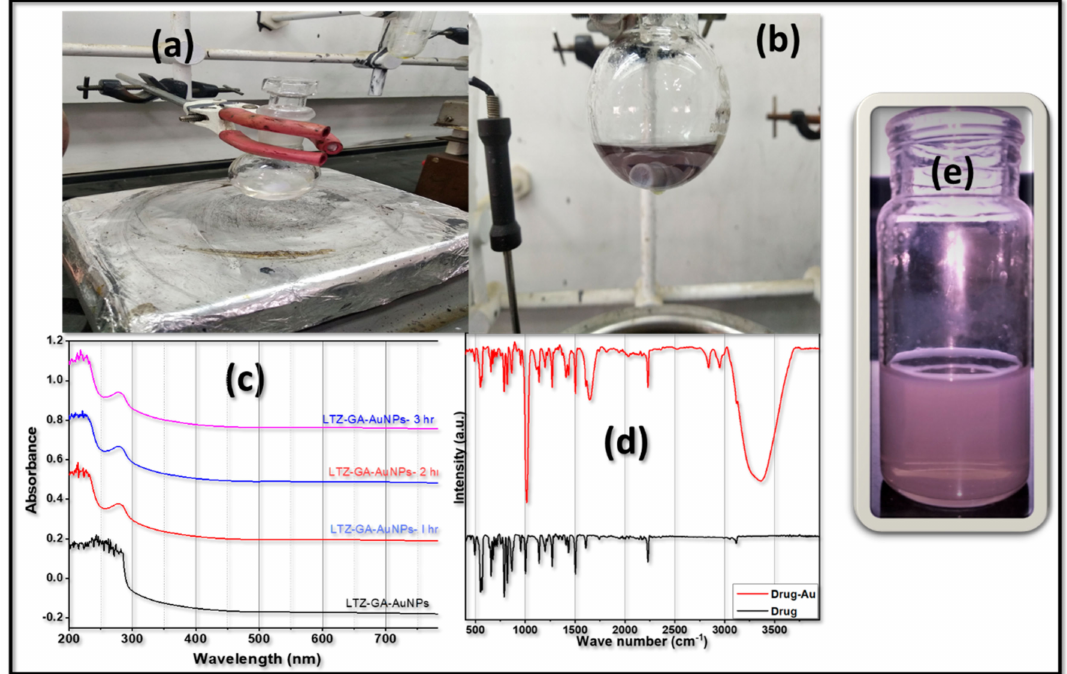
Figure 1. Characterization and chemical structure of LTZ@ GA-AuNPs: ( a , b ) Formation of optimized GA stabilized gold nanoparticles (GA-AuNPs) under natural light in transparent glass; ( c ) UV study of Letrozole-loaded GA-AuNPs; ( d ) Comparative FTIR spectra of drug and drug-Au; ( e ) final optimized